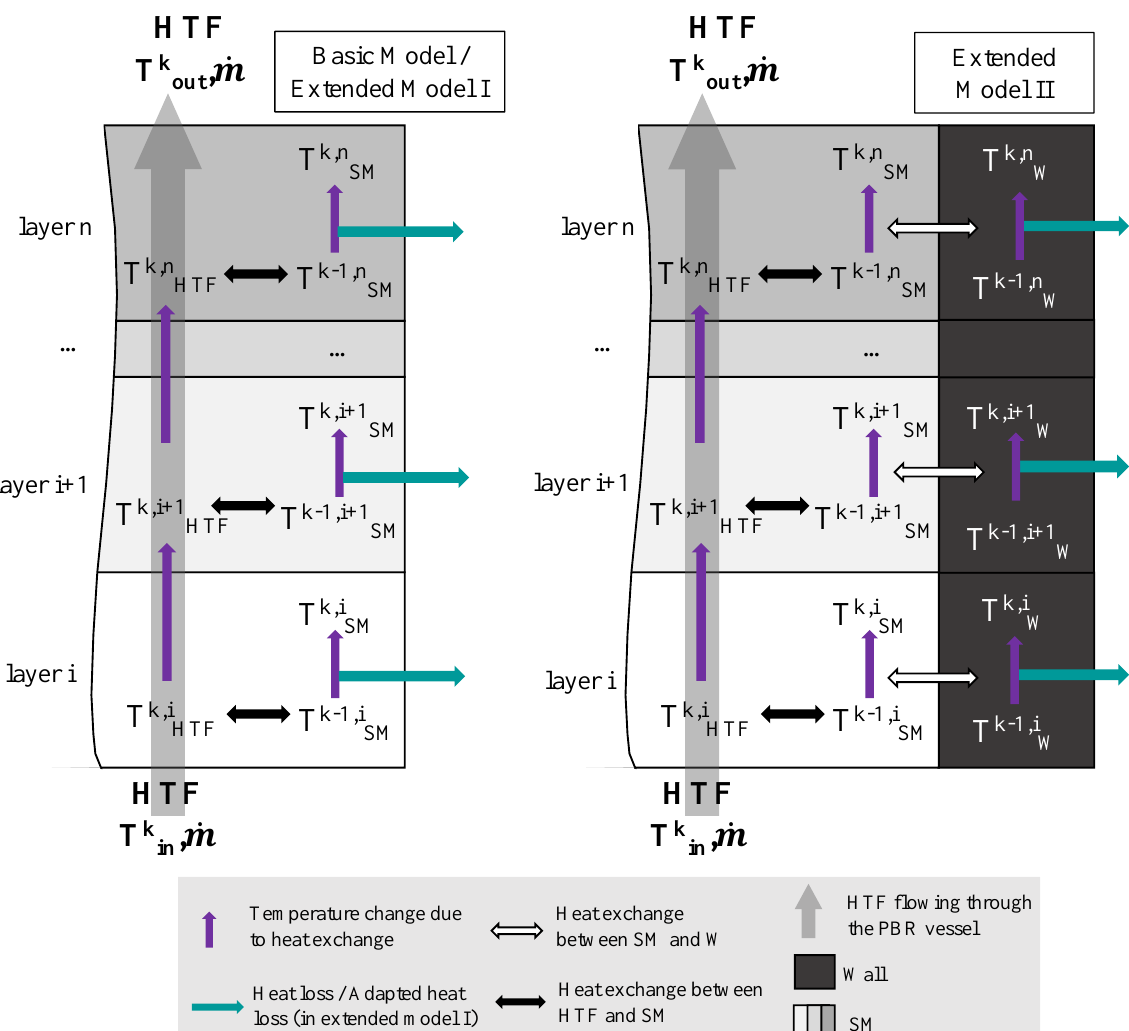
Figure 2. Modeling procedure of the basic model ( left ), extended model I (left, using adapted heat loss), and extended model II ( right